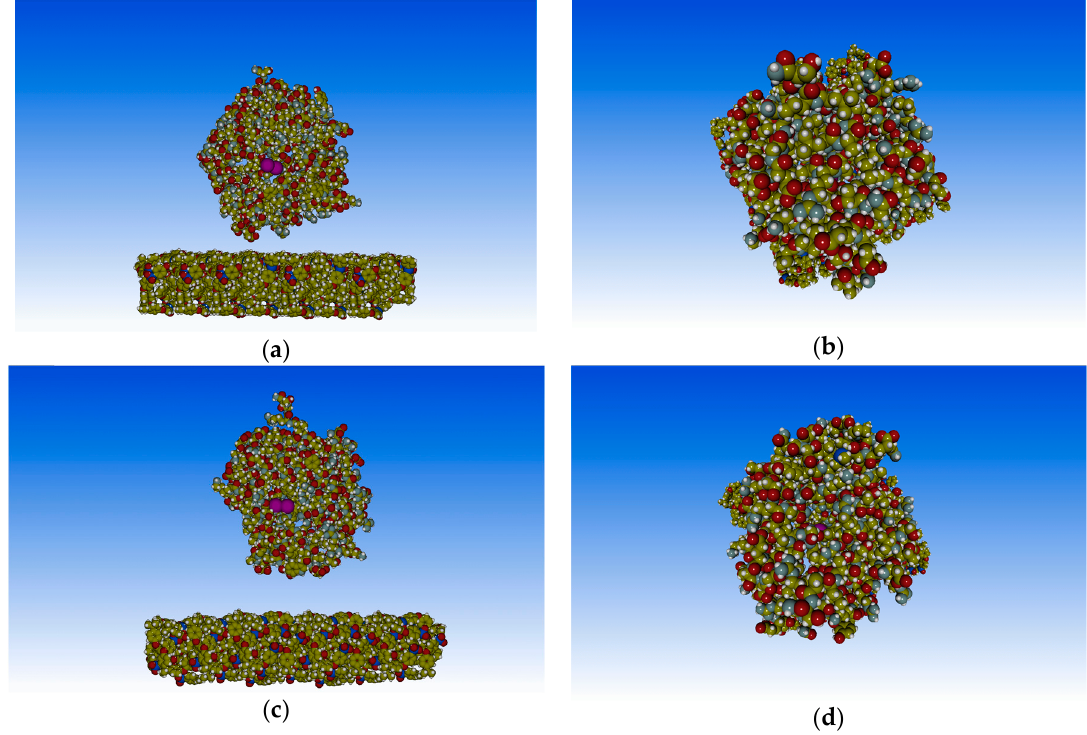
Figure 5. Adsorbed PTE on the PSU model in the local minima. ( a ) Side view and ( b ) top view of the PTE-PSU structure corresponding to minimum with interaction energies of − 97.57 Kcal/mol at d = 27 Å, respectively; ( c ) side view and ( d ) top view of the PTE-PSU structure corresponding to minimum with interaction energies of − 82.44 Kcal/mol at d = 35 Å, respectively. Zinc atoms were shown in fuchsia.